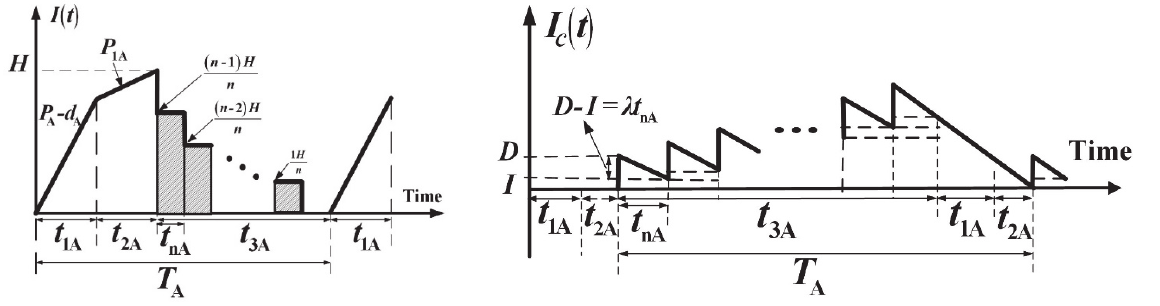
Fig. 4. Status of on-hand stock at the buyer’s